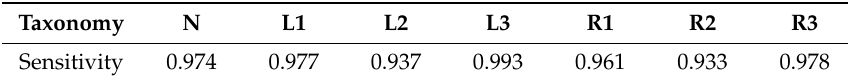
Table 6. Sensitivity for Every